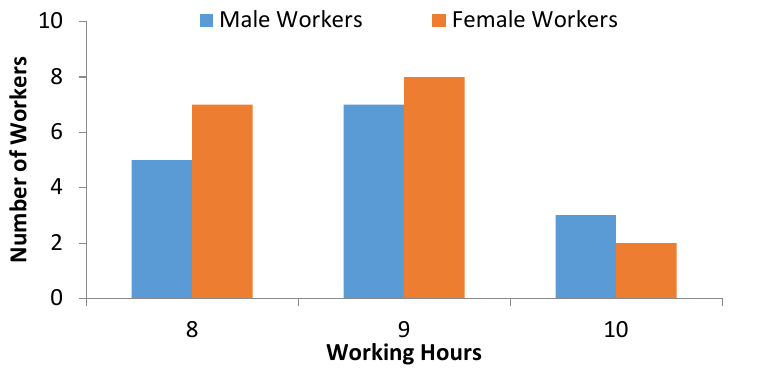
Figure 3. Number of workers with the corresponding working hours.